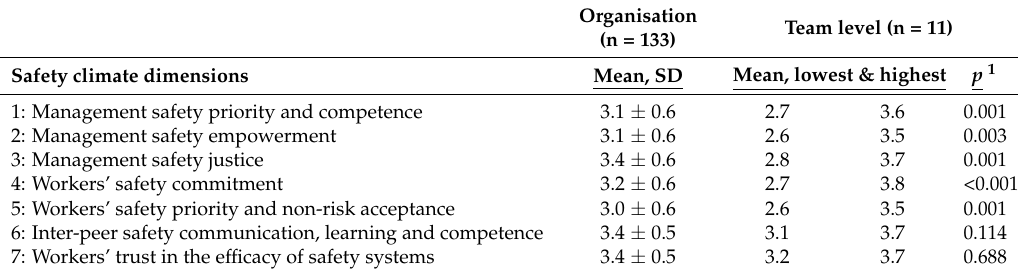
Table 1. Respondent perceptions of the safety